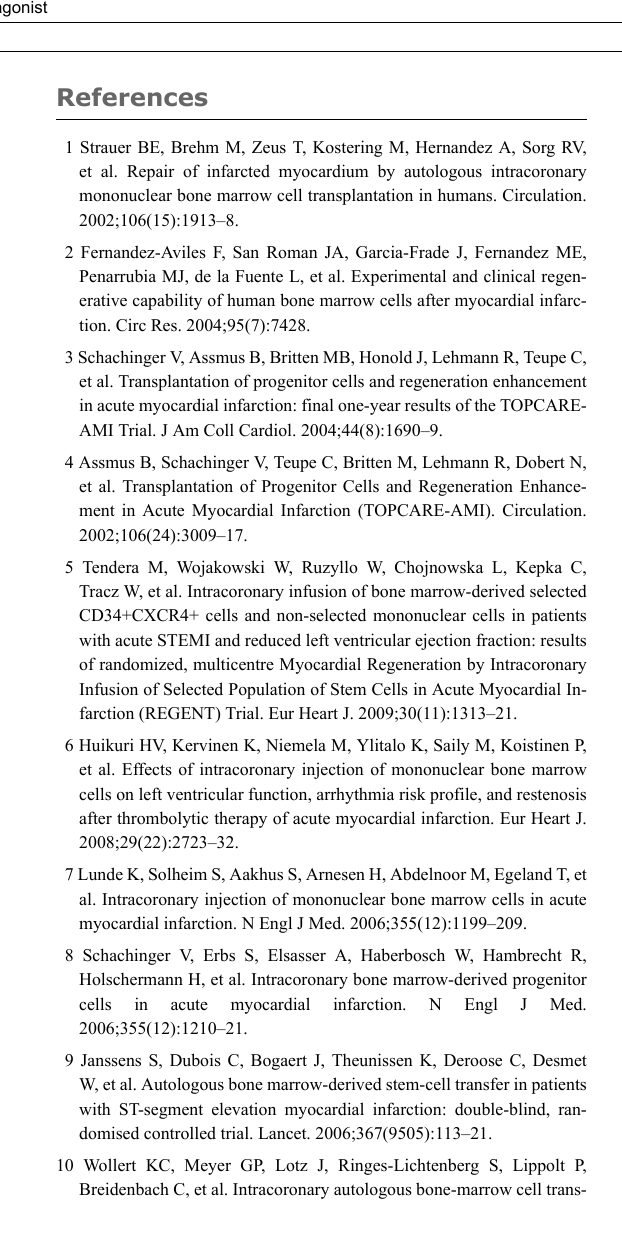
Table 4: Changes over time in left ventricular function according to BM-MNC treatment. Comparison of changes over time is adjusted for baseline values. LV function (mean,